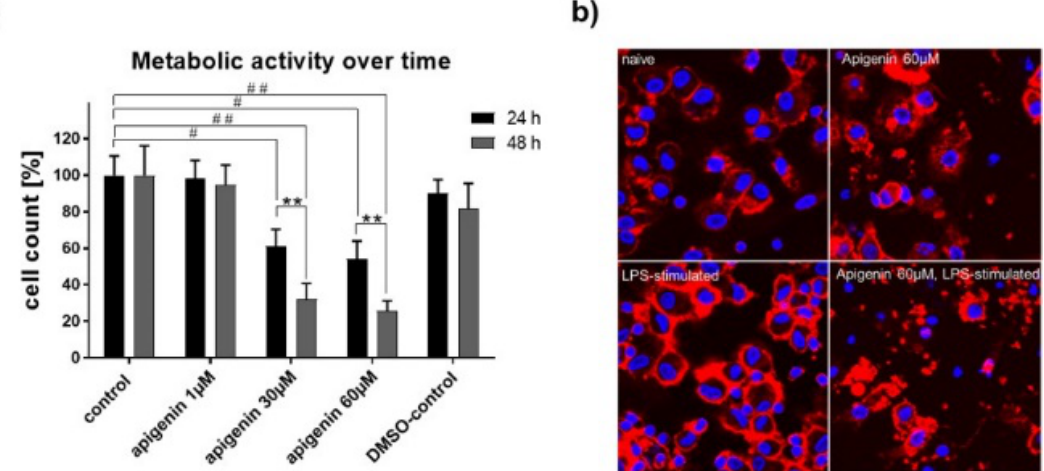
Figure 9. ( a ) XTT assay for metabolic activity of human dendritic cells stimulated with vehicle, Api in different concentrations or DMSO in the presence of LPS for 24 h and 48 h. ( b ) Representative confocal microscopic images of human dendritic cells treated with vehicle or 60 μ M Api in absence (upper panel) or presence (lower panel) of LPS for 48 h (magnification 63x). Data are expressed as mean ± standard deviation (SD); significant differences are indicated as ** p < 0.01; ## p < 0.01, # p < 0.05; n = 4.